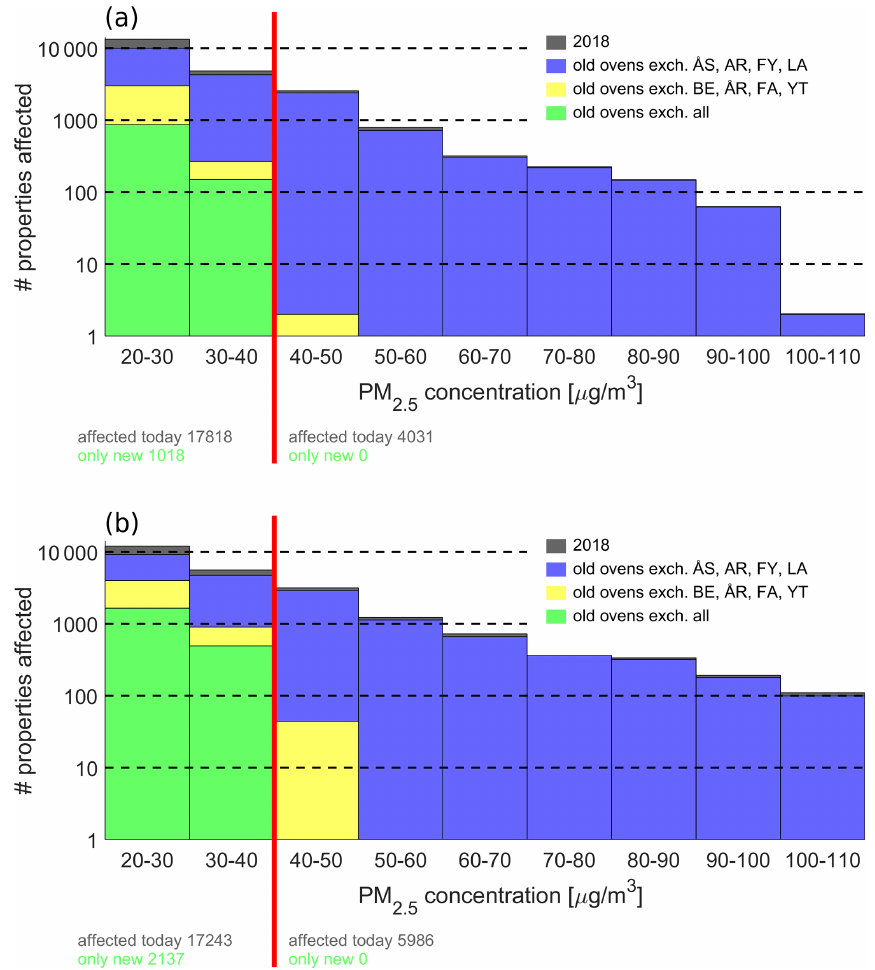
Figure 7. Histogram of the accumulated number of households (number of properties on the y axis given in logarithmic scale) in Bergen that were exposed to different concentrations (the binned concentration intervals on the x axis) for scenarios 1 (a) and 2 (b) . The “2018” (upper part of all columns) means the exposure from the simulations with the current mix of older and new stoves, and “old stoves exch.” means a complete replacement with the new stoves in various subsets of districts (as shown in Fig. 6). The impact of the complete replacement in Åsane (ÅS), Arna (AR), Fyllingsdalen (FY) and Laksevåg (LA) (Fig. 6, bottom) is shown as blue columns; the same in Bergenhus (BE), Årstad (ÅR), Fana (FA) and Ytrebygda (YT) (Fig. 6, top) is shown as yellow columns, and the same in all districts as green columns. The threshold of 40µgm − 3 for PM 2 . 5 concentrations is indicated with a vertical red